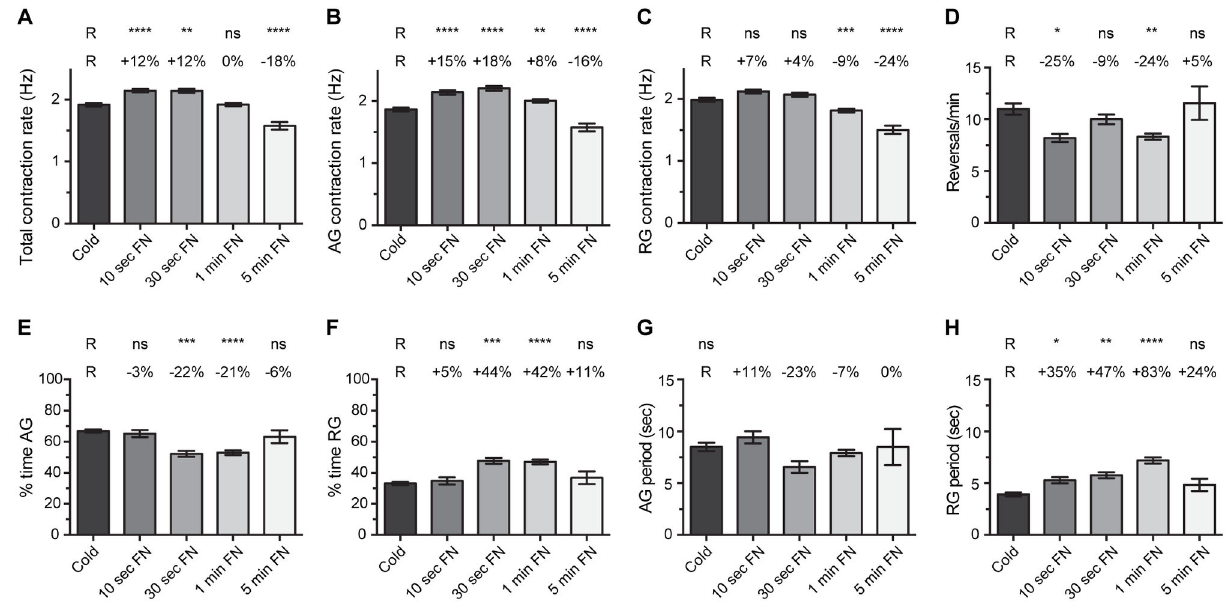
Figure 2. Heart physiology following cold or FlyNap